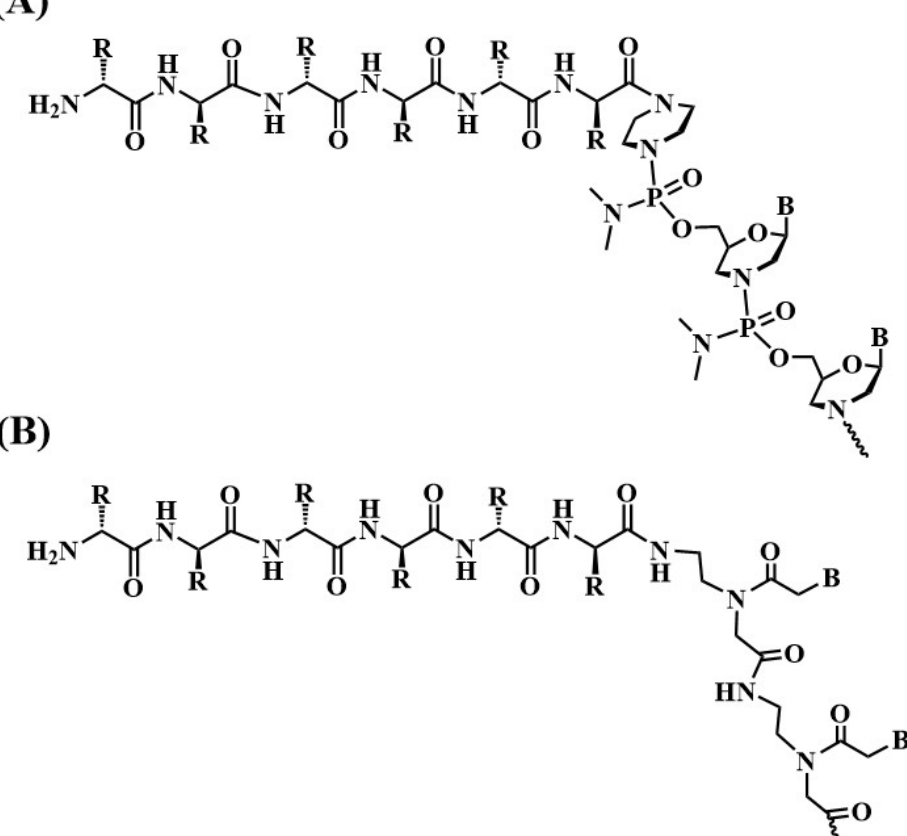
Figure 6. Chemical structure of nucleic acid conjugates for potential therapeutic use. ( A ) Phosphorodiamidate morpholino oligomers (PMO) [197] and ( B ) peptide nucleic acids (PNA) conjugates [198].